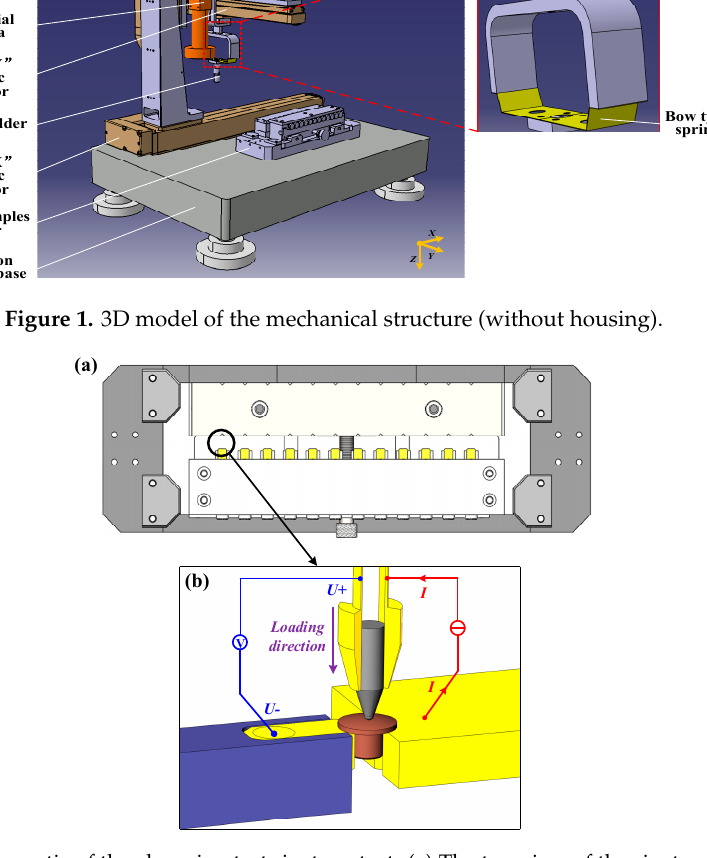
Figure 2. The schematic of the clamping test rivet contact. ( a ) The top view of the rivet samples holder. ( b ) The four-wire configuration including the probe holder structure and the rivet clamping structure of one measurement workstation.